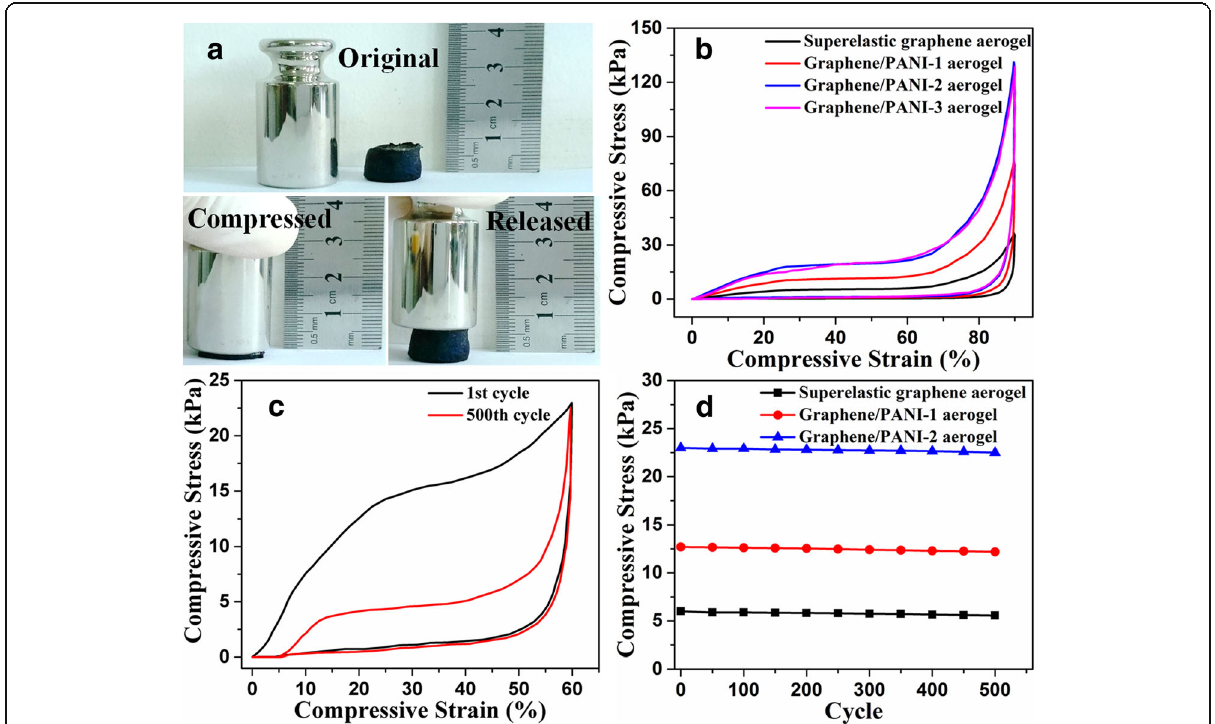
Fig. 5 a Real-time photos of the compression-recovery process of graphene/PANI-2 aerogel. b Compressive stress – strain curves of superelastic graphene aerogel and graphene/PANI aerogels at a set strain of 90%. c Stress – strain curves of 1st and 500th cycles of graphene/PANI-2 aerogel at a set strain of 60%. d Maximum stress values of superelastic graphene aerogel and graphene/PANI aerogels for 500 cycles at a set strain of